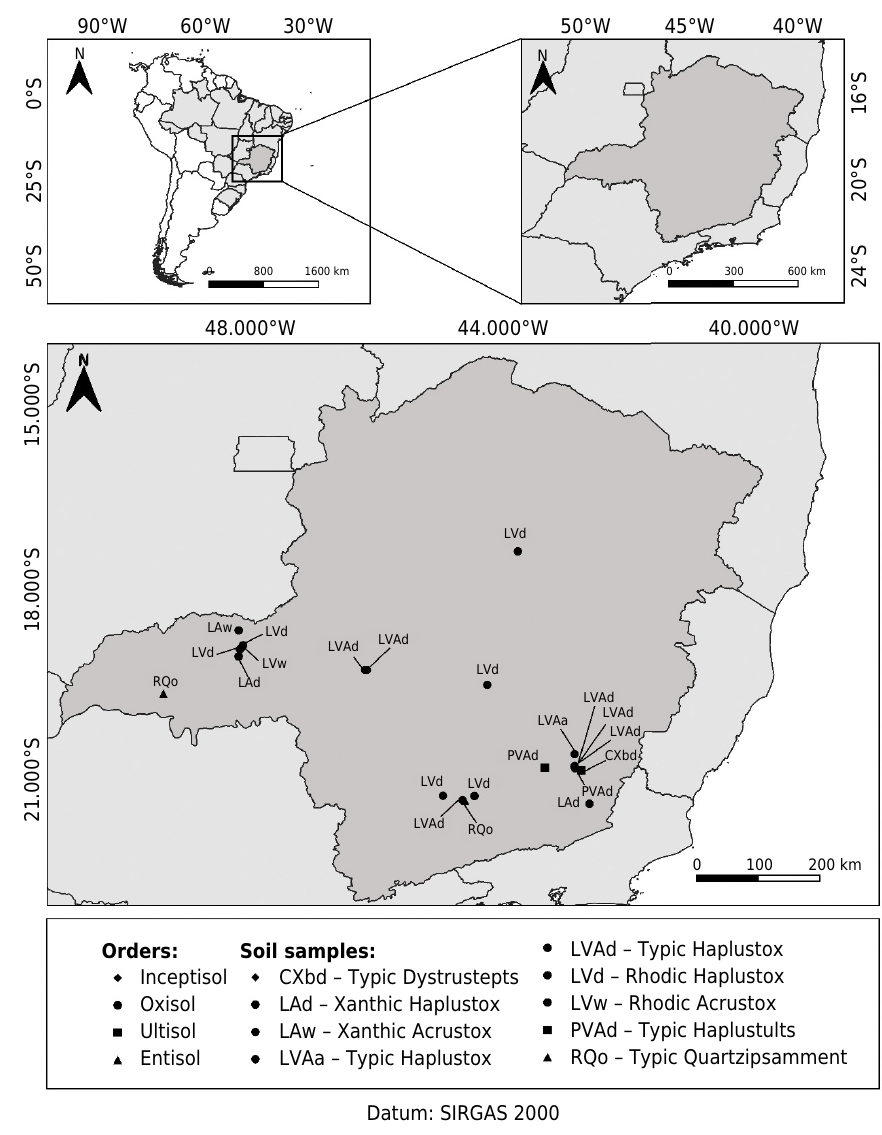
Figure 1. Study area and sampling locations at the Minas Gerais State, Brazil. The soil abbreviations were based on the Brazilian System of Soil Classification (Santos et al., 2013), followed by their Soil Taxonomy (Soil Survey Staff, 2014) nearest